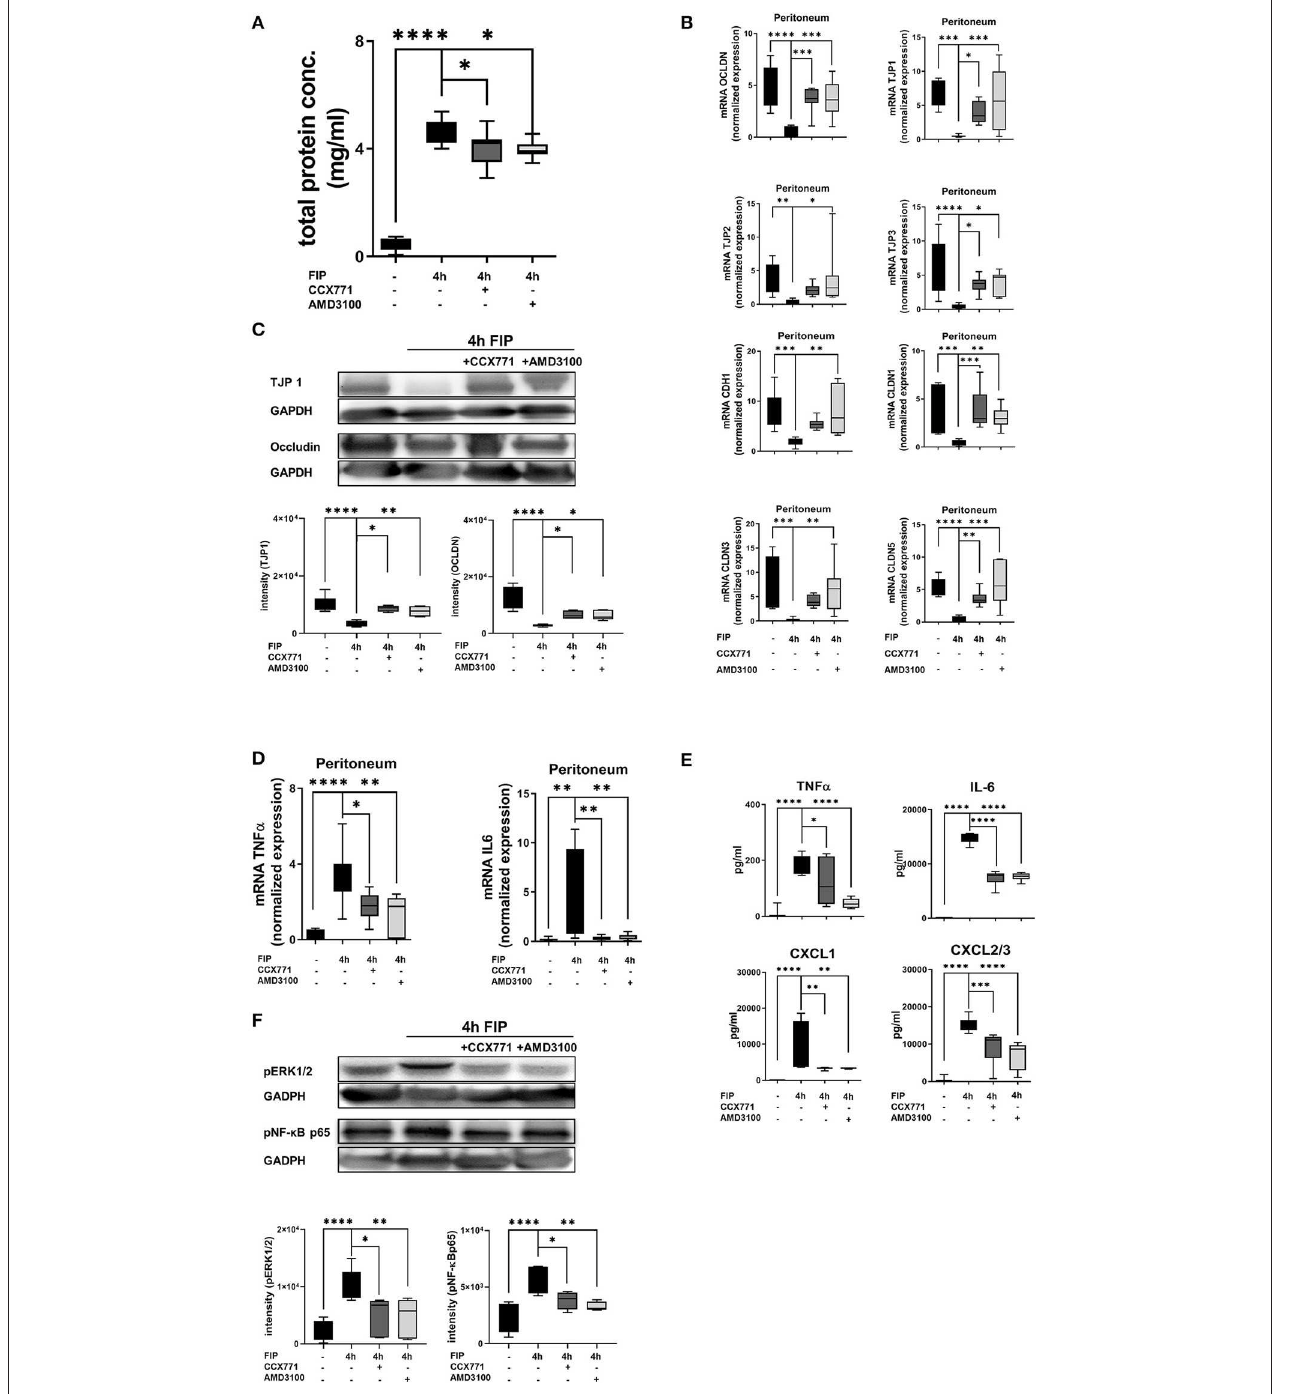
FIGURE 7 | Impact of CXCR4 and CXCR7 inhibition on microvascular permeability and cytokine release during polymicrobial peritonitis. (A) Protein extravasation was evaluated in the peritoneal cavity 4h after fecal solution in wild type animals ( n = 8–12). (B) mRNA of tight junction proteins was measured in peritoneal tissue of wild type animals ( n = 6–12). (C) Protein levels of TJP1 and occludin were quantified in peritoneal tissue (representative blot of n = 3 experiments) and also (D) gene expression of inflammatory cytokines TNF α and IL6 ( n = 6–8). (E) TNF α , IL6, CXCL1, and CXCL2/3 release was determined in the peritoneal cavity at indicated time points and conditions ( n = 8). (F) Effects of CXCR4- and CXCR7 blockade on the phosphorylation of ERK1/2 and NF- κ B subunit 65 in peritoneal tissue of wild type were identified (representative blots of n = 3 experiments). Intensity of the blots was evaluated by ImageJ. For statistical analysis, one-way ANOVA was used with Bonferroni post-hoc test. Data are presented as box and whisker graph with error bars indicating the range from minimum to maximum value; * p < 0.05; ** p < 0.01; *** p < 0.001, and **** p < 0.0001.